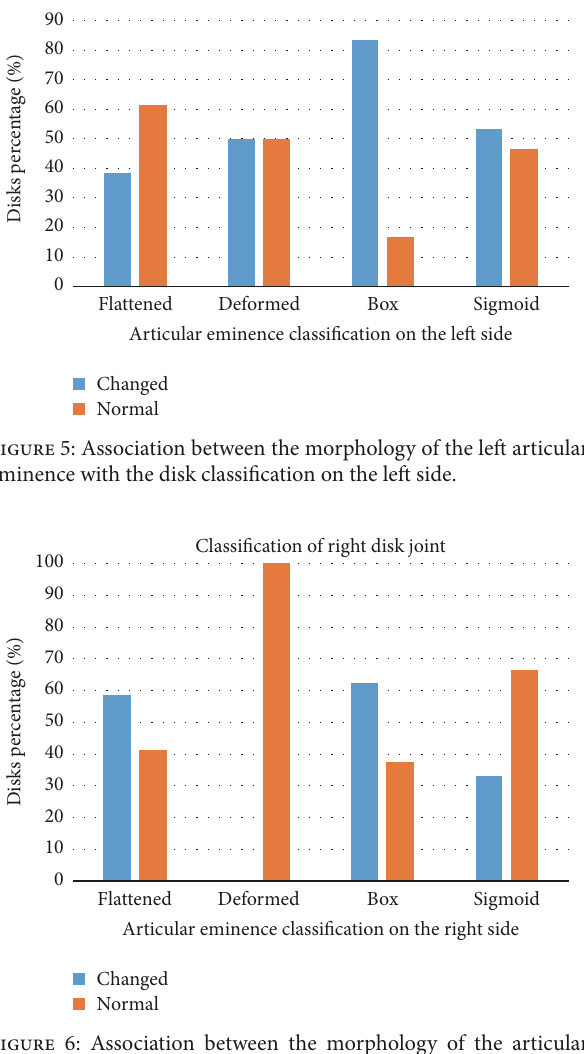
Figure 6: Association between the morphology of the articular eminence and disk classification on the right side.